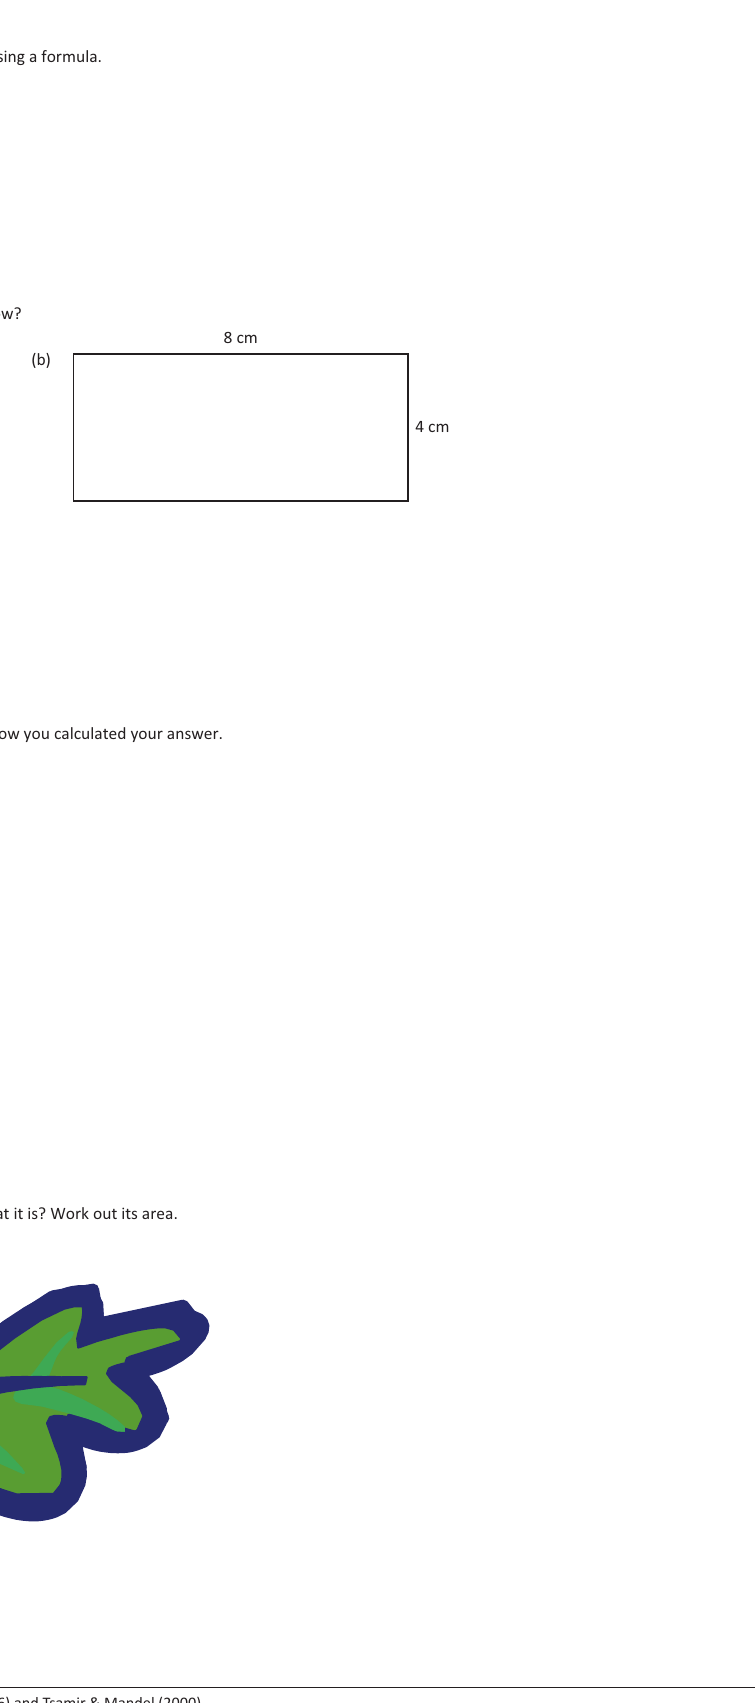
FIGURE 1: The written test on area and